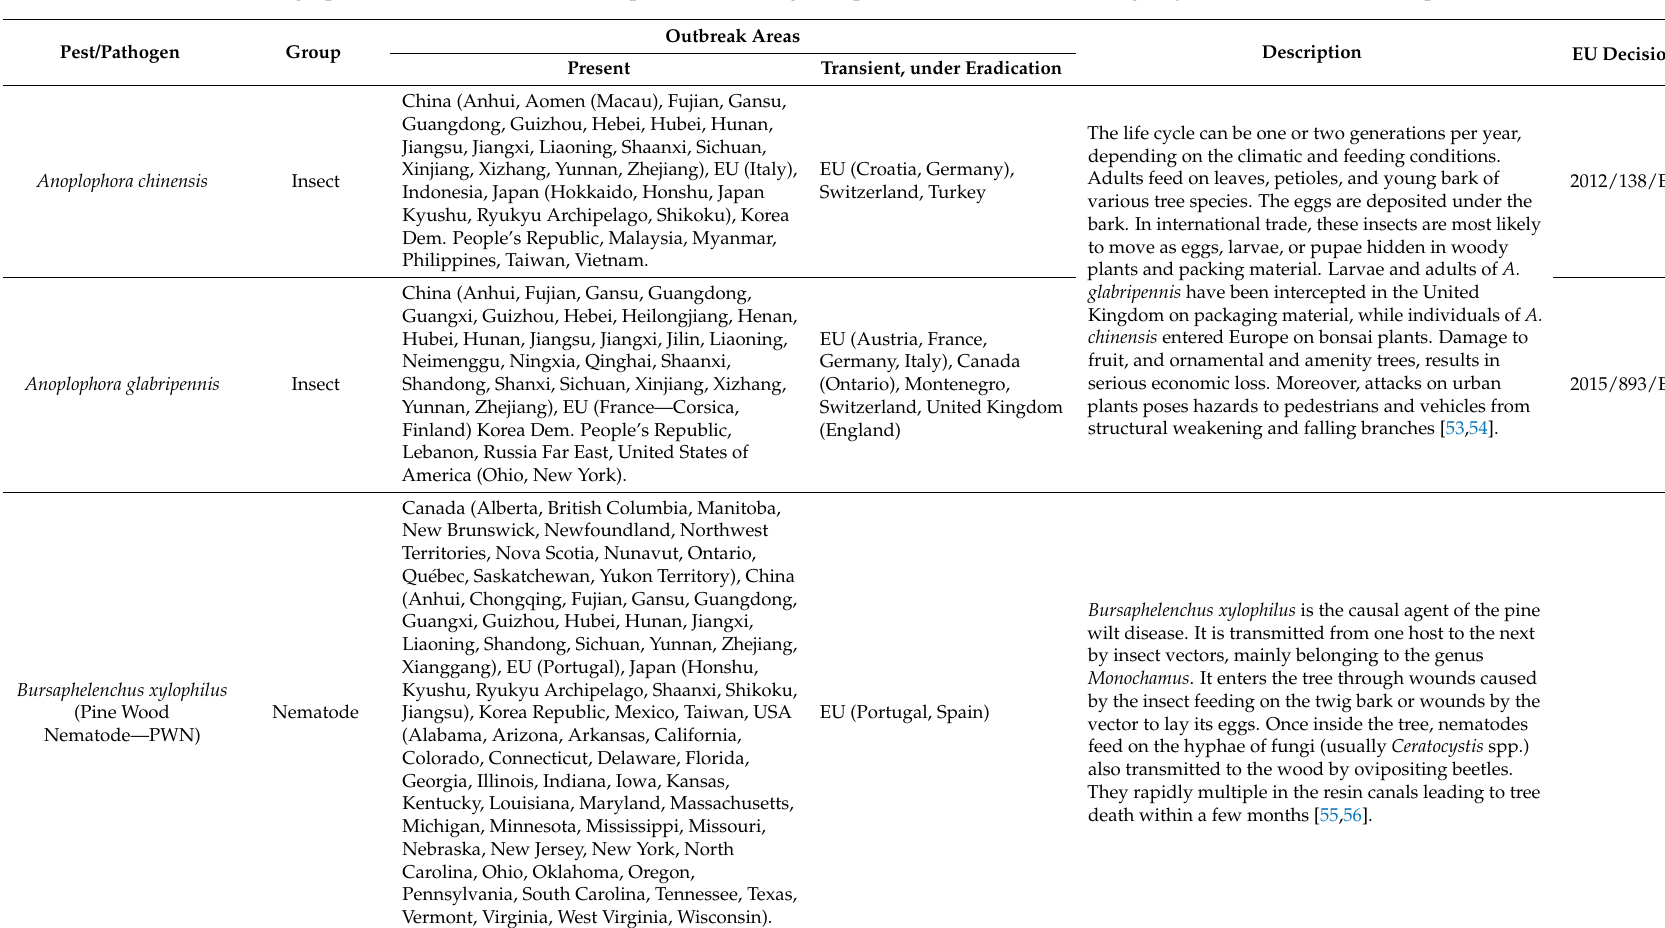
Table 2. Geographic distribution and status of pests threatening European forests for which emergency measures have been